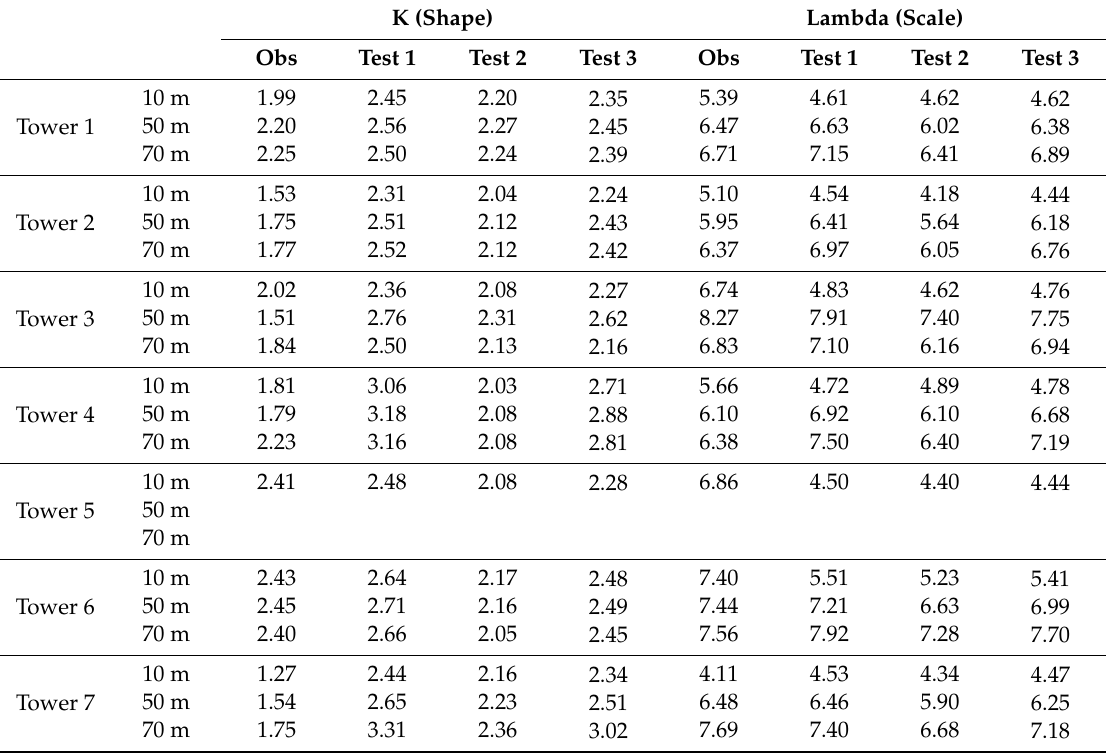
Table 8. Shape and scale parameters of the Weibull